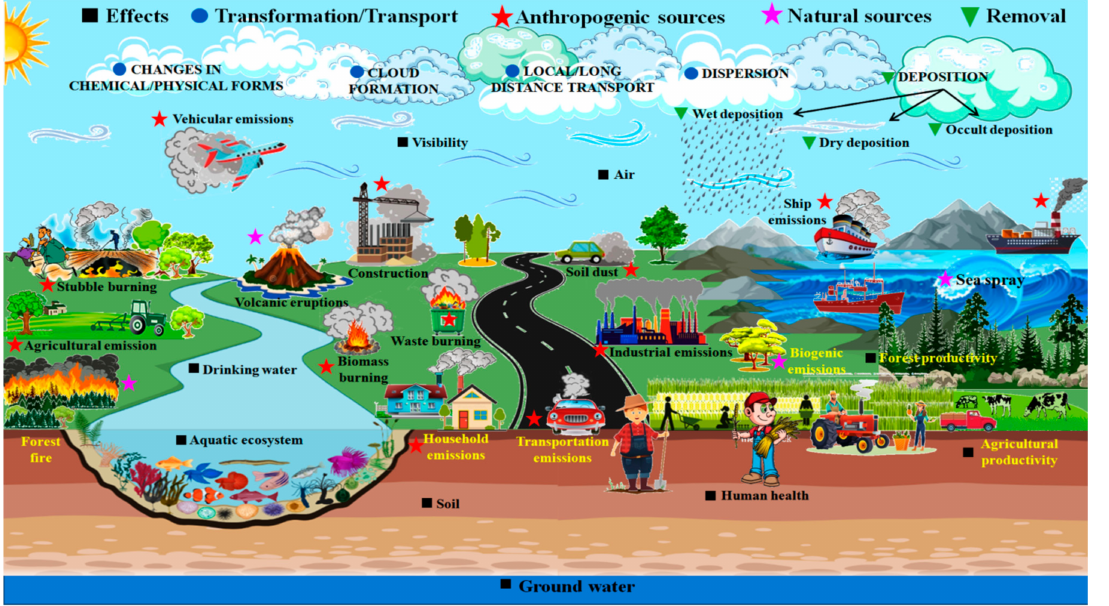
Figure 1. A diagrammatical representation showing the different sources of PM pollution (natural and anthropogenic) that can affect different ecosystems. PM can change chemical and physical forms and form a cloud in the air, and can be dispersed and transported long/local distances. PM is deposited (wet, dry, occult) in the environment by three different types of